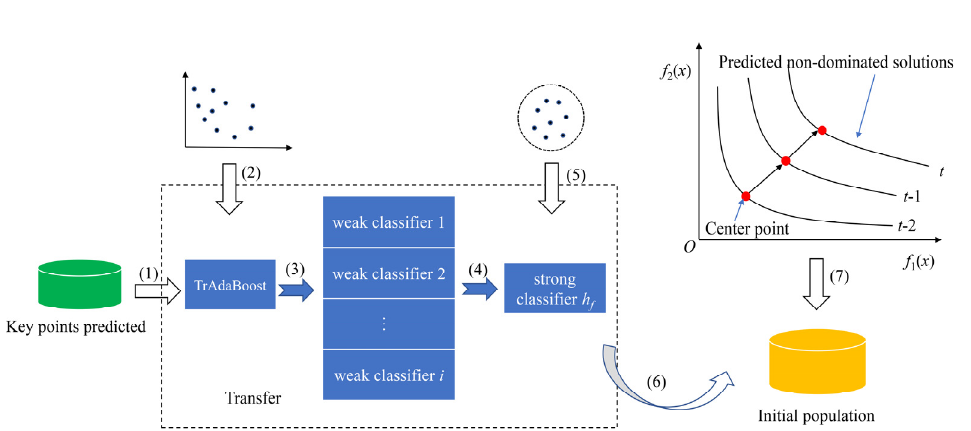
Figure 4. The procedure for initial population consisting of transfer and center-point-based prediction together. Steps 1 and 2: The predicted key points and the solution obtained at the previous moment are put into the TrAdaBoost. Steps 3 and 4: TrAdaBoost generates some weak classifiers and then integrates them into a strong classifier h f . Step 5: A significant number of randomly generated individuals are infused into h f . Steps 6 and 7: The good individuals identified by h f and the individuals predicted by the feed-forward model based on center point together constitute the initial population.